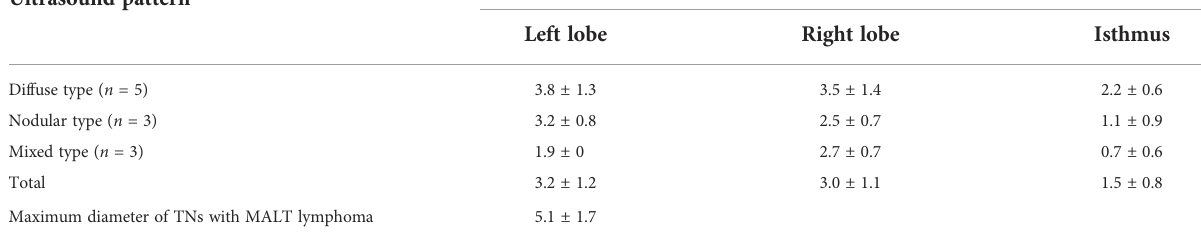
TABLE 1 The size of thyroid MALT lymphoma in three ultrasound patterns at diagnosis ( n = 11). Ultrasound pattern